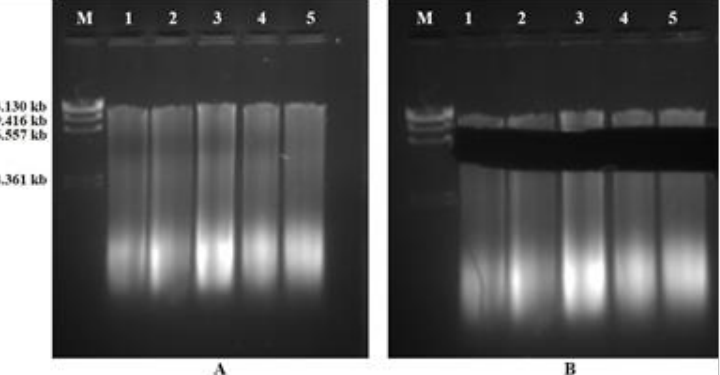
Figure 6. Partial restriction profile of Swarnaprabha genomic DNA. ( A ) Standardization of restriction of genomic DNA with Eco RI was carried out for 20′ (Lane 1), 40′ (Lane 2), 60′ (Lane 3), 90′ (Lane 4), and 120′ (Lane 5) durations. ( B ) Excised genomic size of 4 – 9 kb for ligation into pBluescript vector.